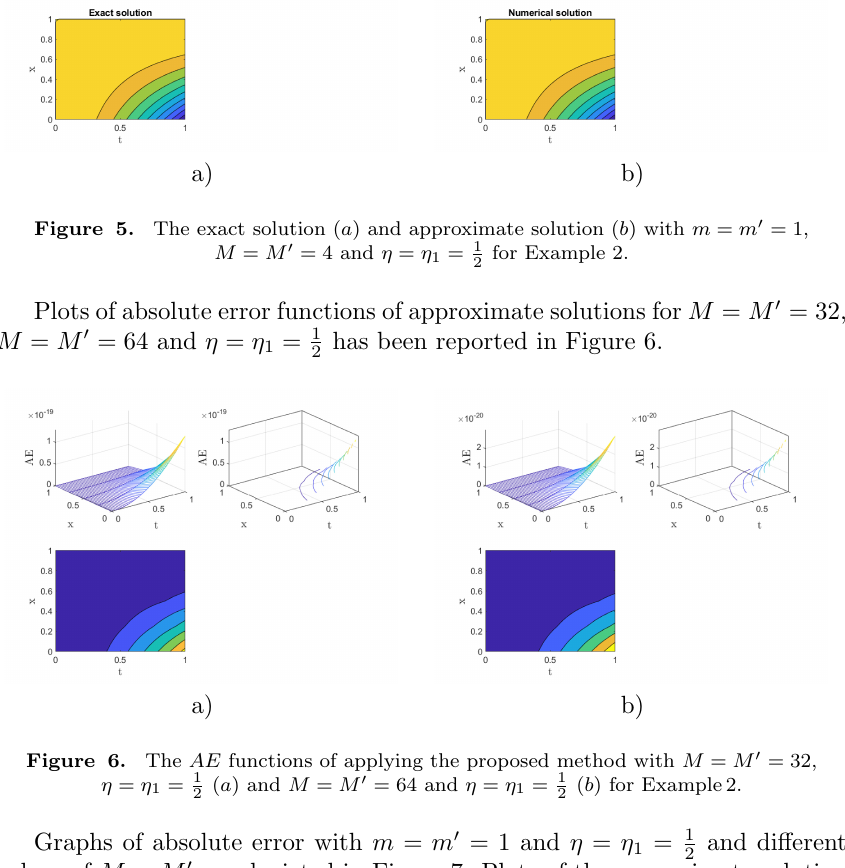
( b ) for Example2. 2 and different 2